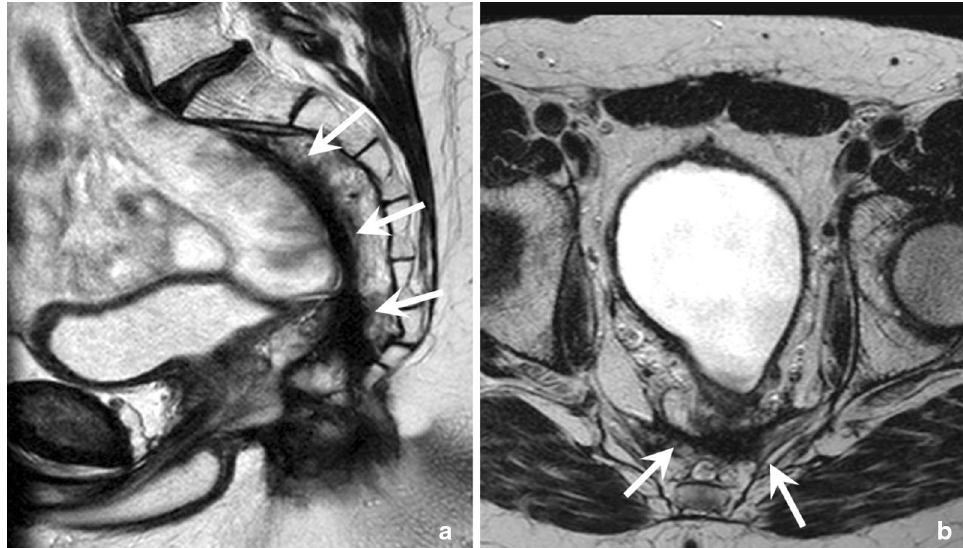
Fig. 15 Sagittal ( a ) and axial ( b ) T2‑weighted images of a 41‑year‑old male patient who underwent an abdominoperineal resection for a ypT3N2 low rectal tumour. Note the extensive post‑operative fibrotic changes (white arrows). These are part of the normal post‑operative spectrum and should not be mistaken for residual or recurrent